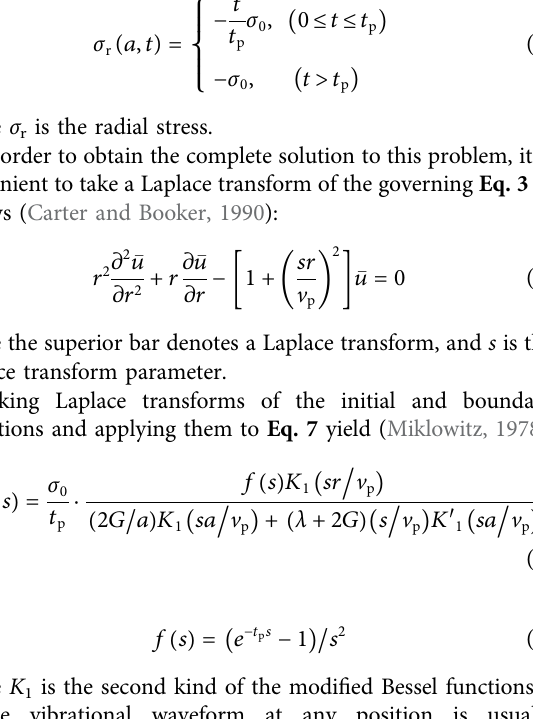
Figure 3 . The stress fl uctuations give rise to higher circumferential stress and lower radial stress than the fi nal static stress values in a transient time. This causes greater deviatoric stress and thus produces a larger compression-shear damage zone around the excavation under high in situ stress conditions. Beyond the damage zone, the stress waves continue to spread outward as elastic seismic waves, thereby inducing vibration in the surrounding rock